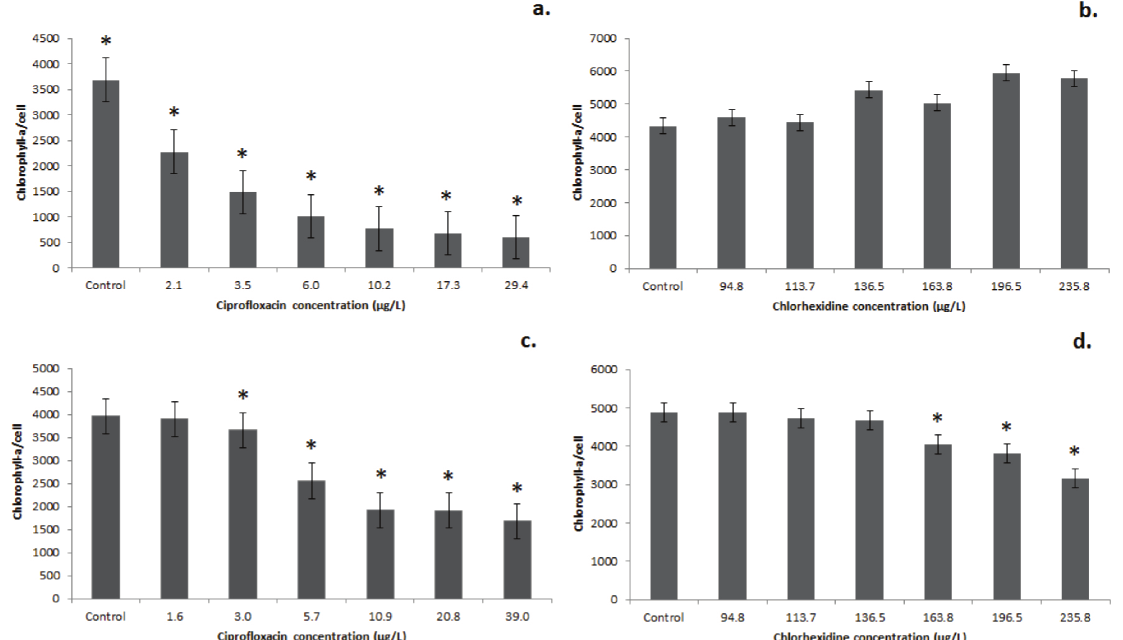
FIGURE 3 - Chlorophyll a/cell after 96 hours of exposure of M. aeruginosa to ciprofloxacin (a) or chlorhexidine (b); and of M. panniformis to ciprofloxacin (c) or chlorhexidine (d). (*) indicates a significant difference between the control and the tests (P